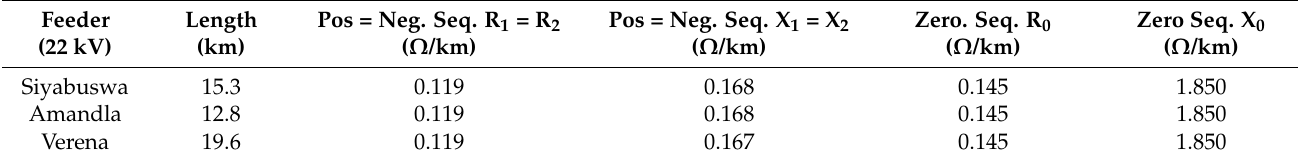
Table 5. Distribution line